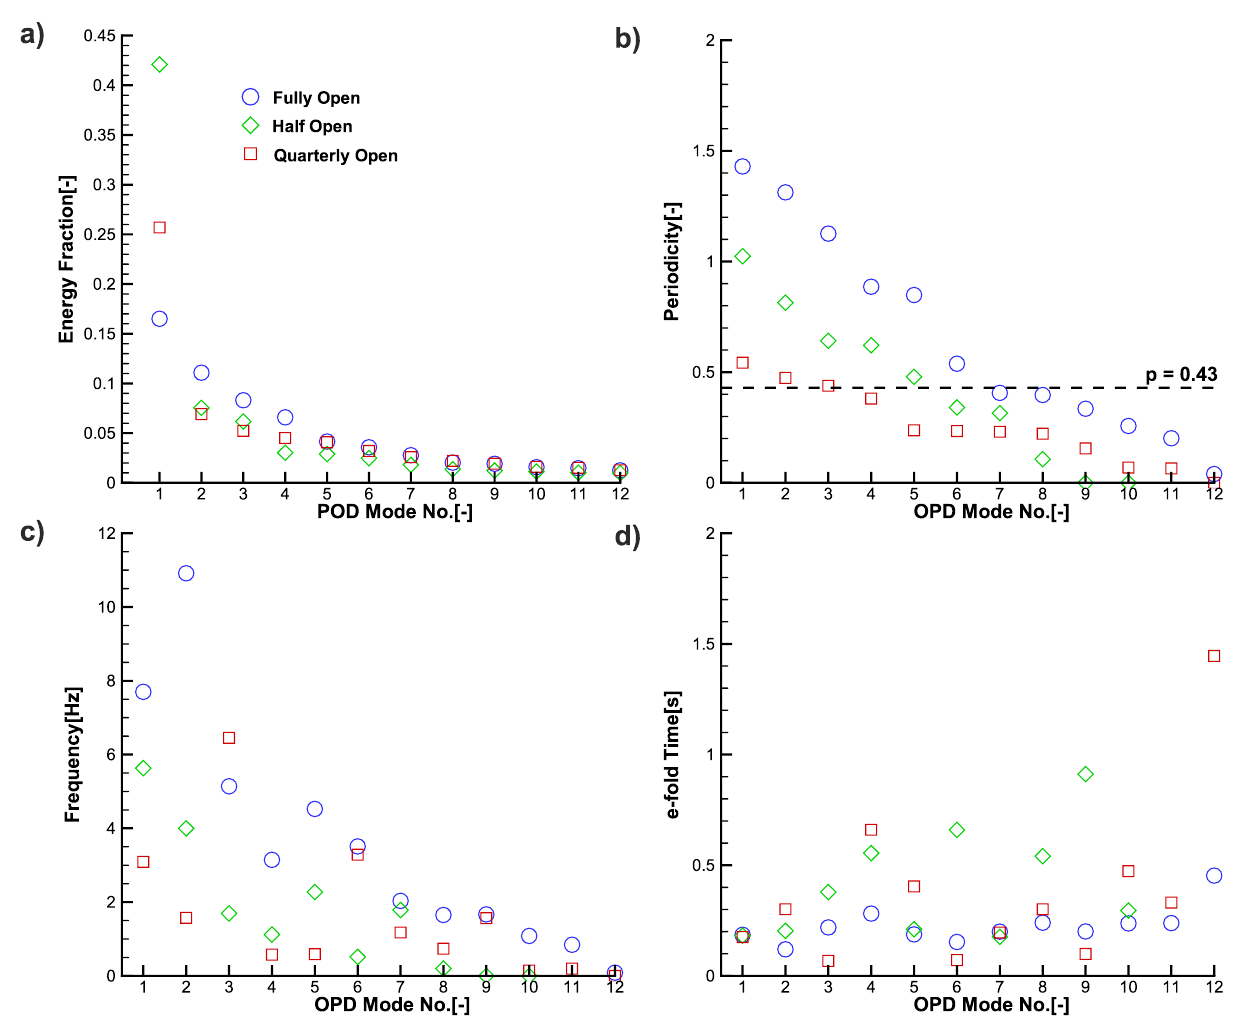
Fig. 4. Computed modes from POD ( a ) and OPD ( b,c,d ) analysis. The dashed line in (b) represents the threshold periodicity ( p = 0.43) suggested by Uruba